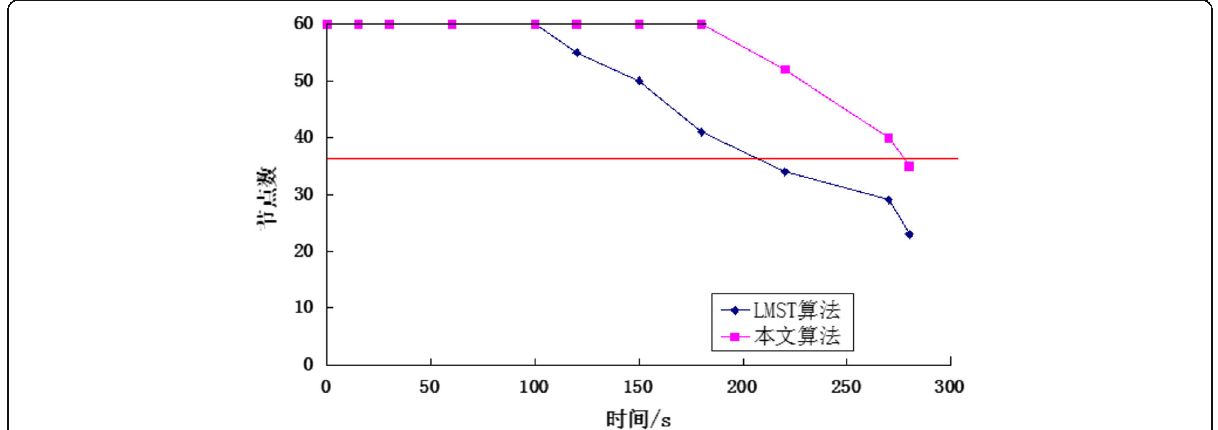
Fig. 2 Comparison of network lifetime curves under this algorithm and LMST algorithm